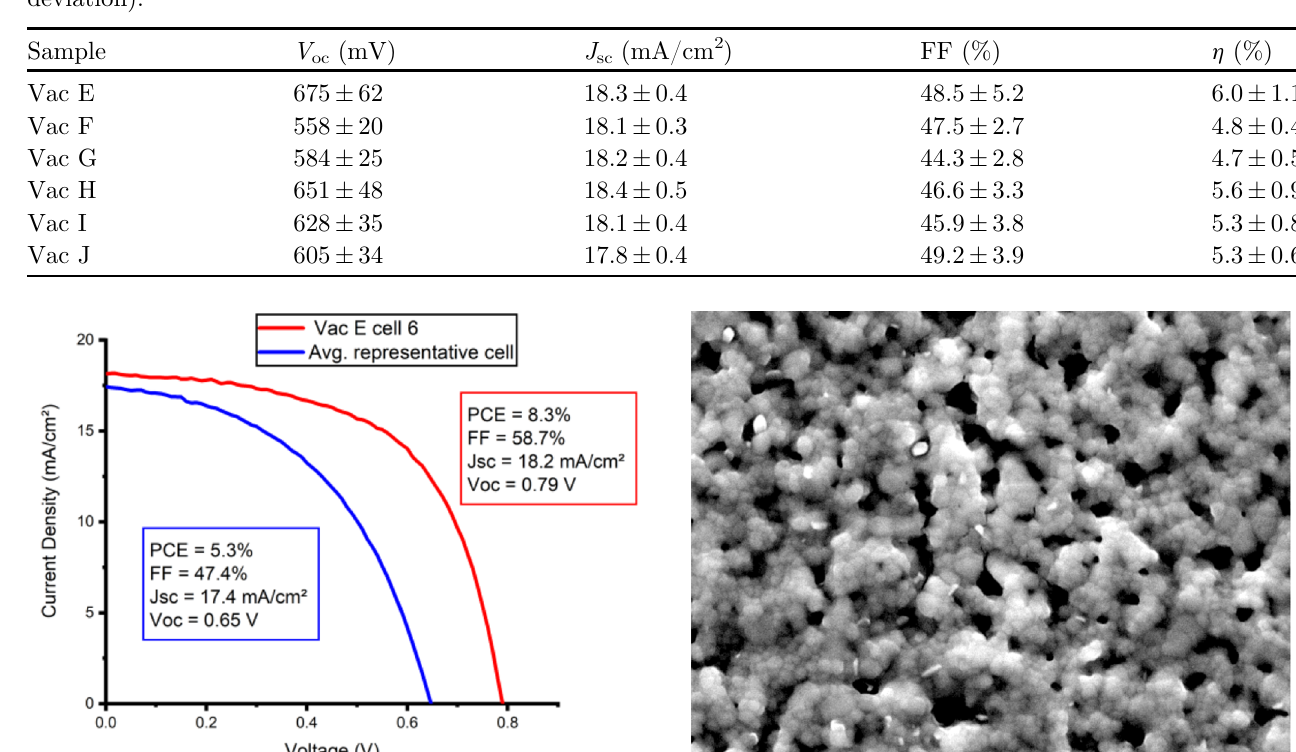
Table 1. Average performance of perovskite solar cells fabricated by USSC and vacuum quenching (with standard deviation).